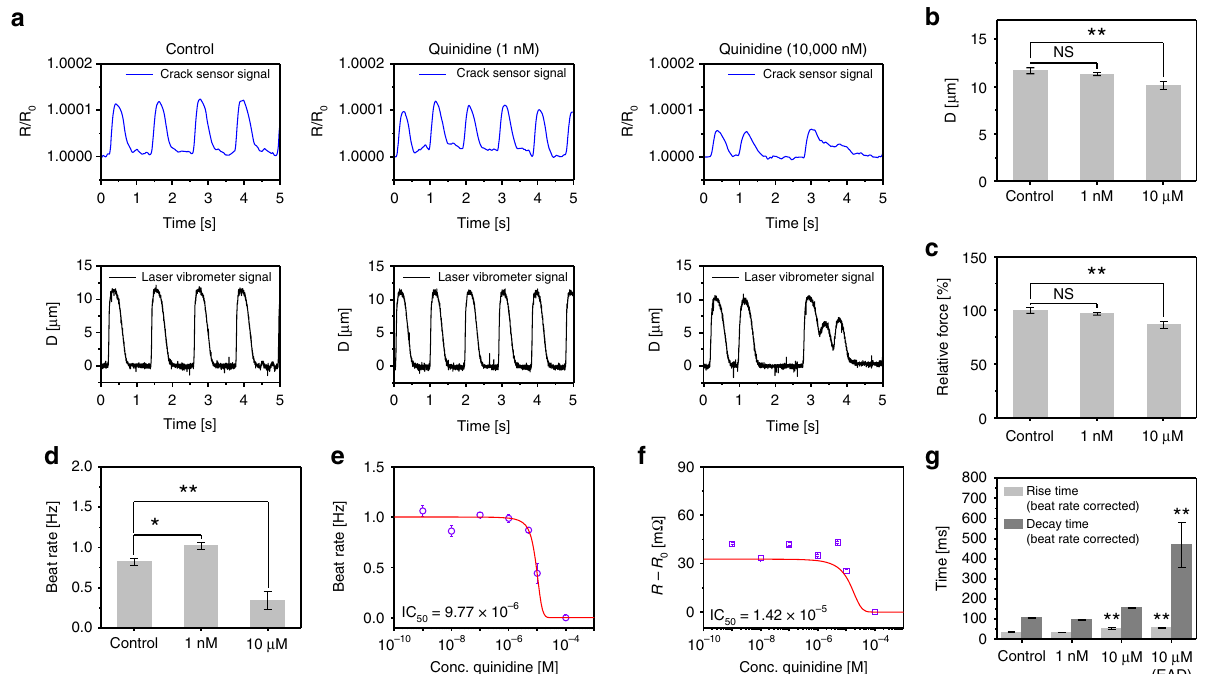
Fig. 7 Change in contractility of the quinidine treated cultured cardiomyocytes. a Representative real-time traces of change in sensor resistance ratio and cantilever displacement owing to the contraction and relaxation of different concentration of quinidine treated cardiomyocytes. b , c Bar plot depicting the cantilever displacement and relative contraction force generated by cardiomyocytes (** p < 0.01 measures by one-way ANOVA followed by Tukey ’ s honest signi fi cant difference test.). d Beat rate of cardiomyocytes at quinidine concentrations of 1 nM and 10 µ M. e Beat rate of quinidine treated cardiomyocytes at different concentrations (1 nM – 100 µ M). f Change in resistance of the cardiomyocytes seeded cantilever at different quinidine concentrations (1 nM – 100 µ M). g Rise time and decay time of cardiomyocytes at quinidine concentrations of 1 nM and 10 µ M. The rise time and decay time were analyzed and beat rate corrected with Fridericia ’ s formula (Rise time corrected (Rc) = R/interspike interval 1/3 ) and (Decay time corrected (Dc) = D/interspike interval 1/3 ), respectively. (* p < 0.05, ** p < 0.01 measures by one-way ANOVA followed by Tukey ’ s honest signi fi cant difference test.). Error bars are mean ± s.d. ( n = 5 biologically independent samples). D is